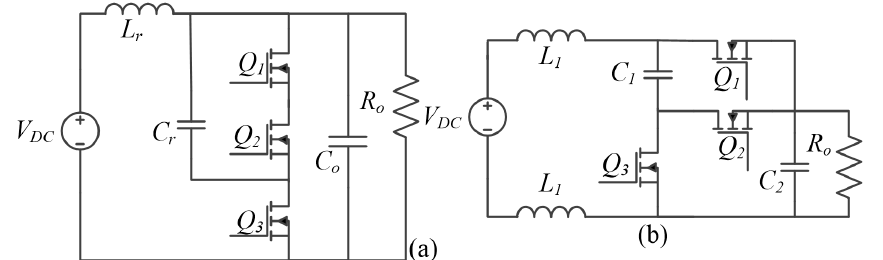
Figure 9. Single-path hybrid converters having ( a ) single, and ( b ) distributed inductors at the input port.